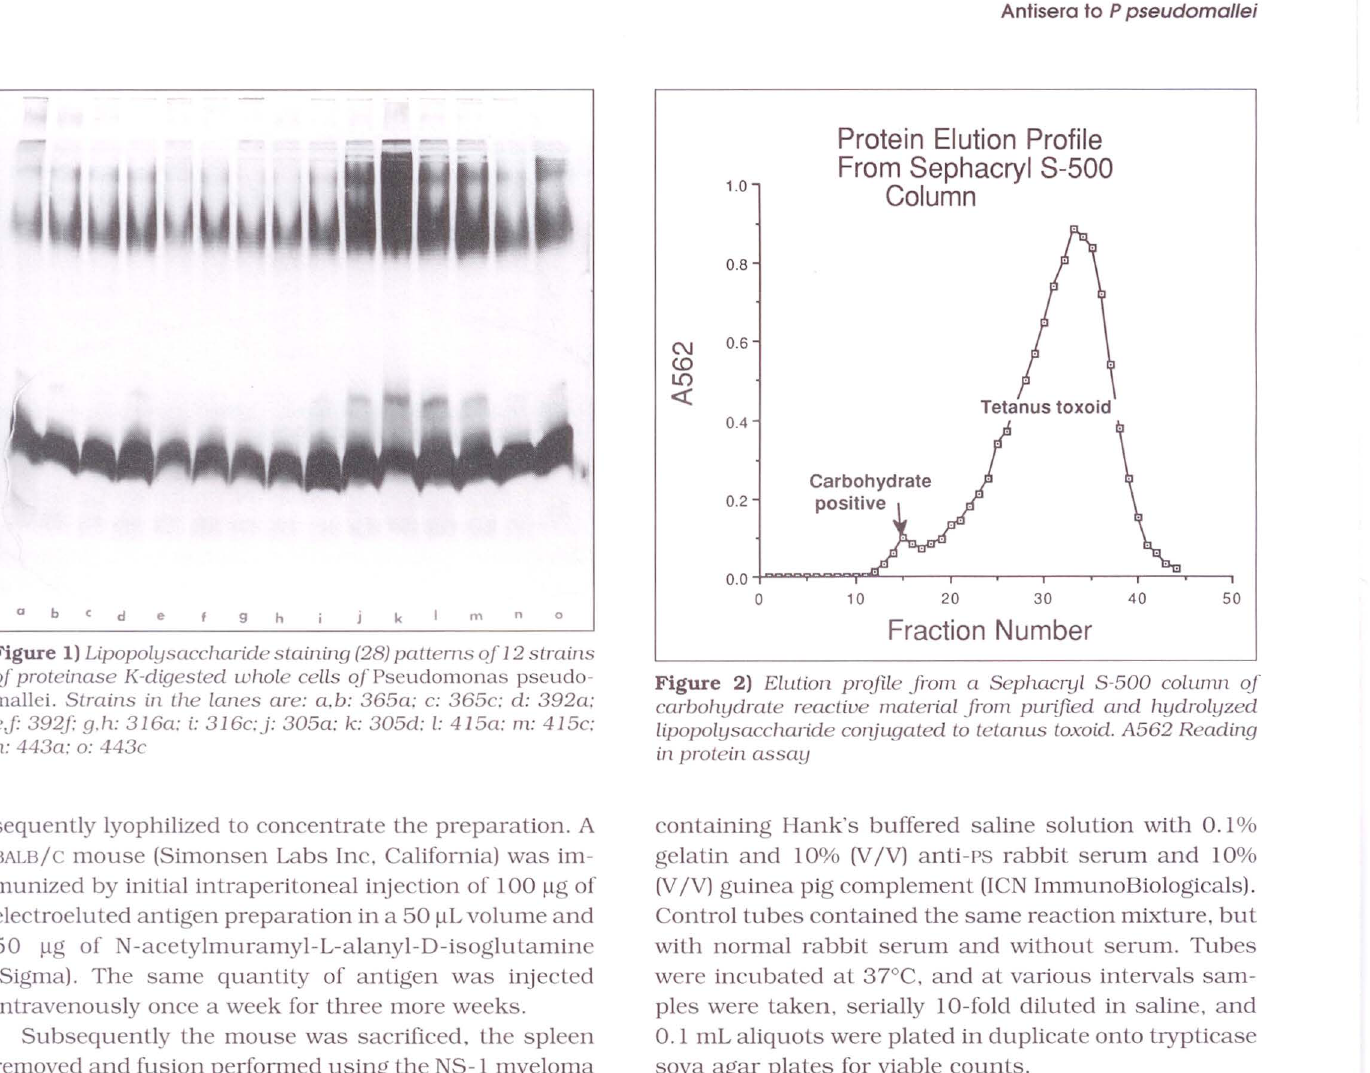
Figure 2) Elution profile from a Sephacryl S-500 coLumn of carbohydrate readiue material from purified and hydrolyzed lipopolysaccharide coryugated to tetanus toxoid. A562 Reading in protein